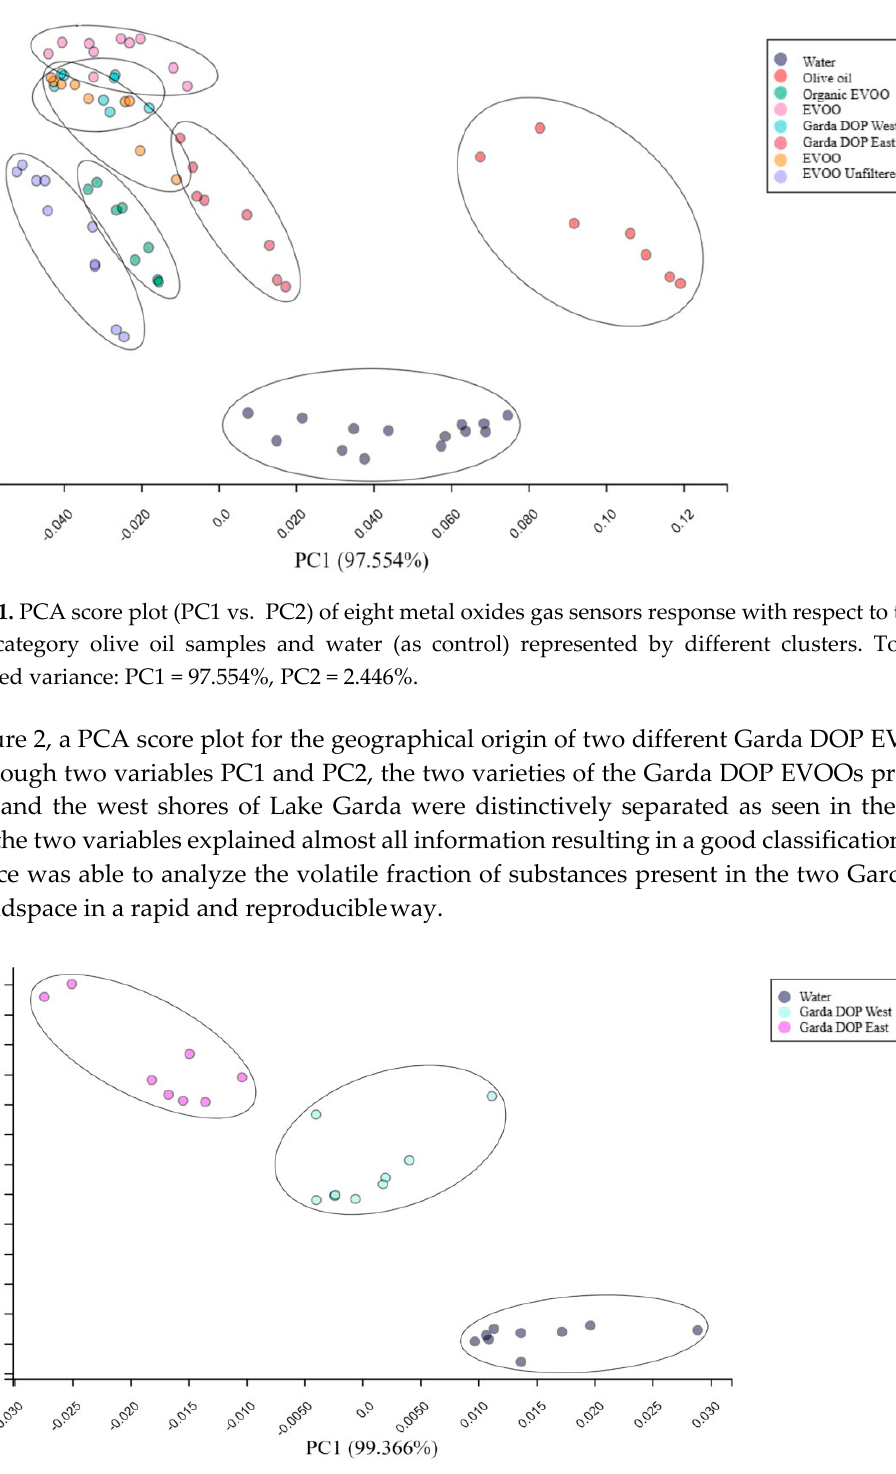
Figure 2. PCA score plot (PC1 vs. PC2) of eight metal oxides gas sensors performed on the Garda DOP East and the Garda DOP West EVOO samples represented by two different clusters. Total explained variance: PC1 = 99.366%, PC2 =